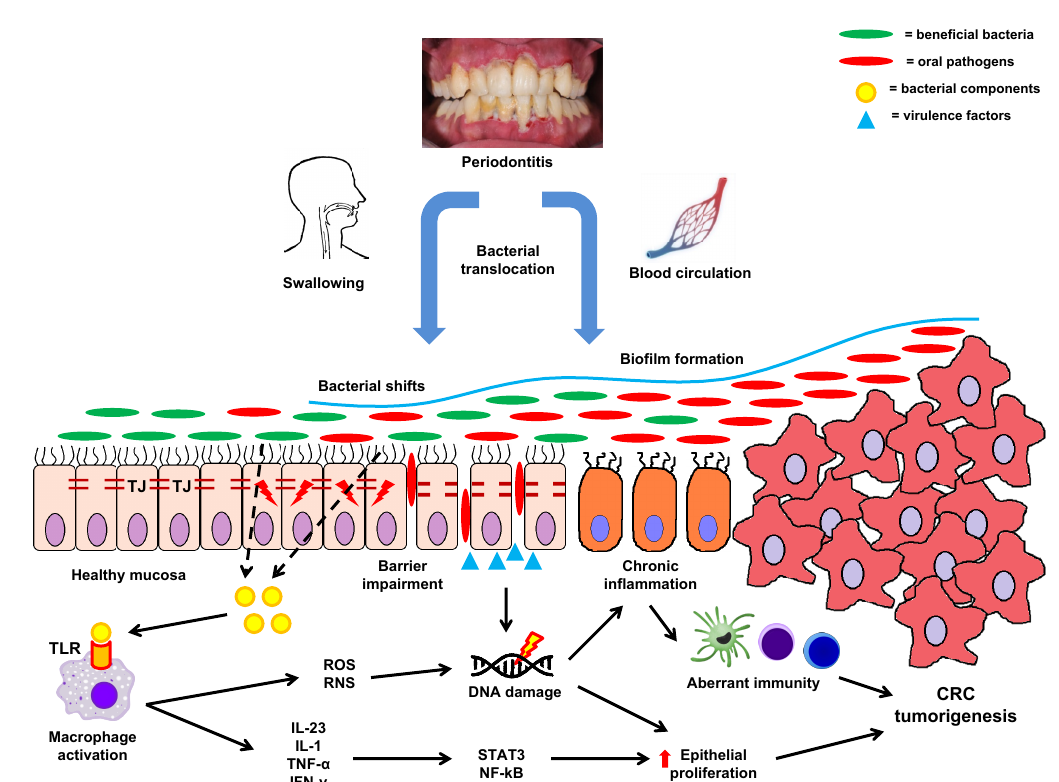
Figure 2. A proposed model of orally-driven intestinal dysbiosis in CRC development. In periodontitis several oral pathogens, such as Fusobacterium nucleatum or Porphyromonas gingivalis , are abundant in oral biofilms. This situation aids the dissemination of oral pathogens into the colon via either swallowing of the saliva or bloodstream. In the colonic environment they are incorporated into the intestinal microbiota. As a result, bacterial shifts and the production of virulence factors create a microbiotic instability and outgrowth of pathogens leading to intestinal dysbioisis. Subsequent biofilm formation and secretion of several bacterial components (e.g., metabolites, toxins, MAMPs), lead to macrophage activation and disruption of the mucosal barrier. Pro-inflammatory cytokines, such as IL-23, IL-1, TNF- α , and IFN- γ , enable signaling pathways through STAT3 and NF- κ B activation, enhancing the proliferation of epithelial cells. Moreover, the release of ROS and RNS and the increased exposure of submucosal environment by virulaence factors and other bacterial products or toxins result in DNA damage and mutations. These events promote a chronic inflammatory state which stimulates an aberrant immune response and further impairs the colonic epithelium. Inevitably, the result of the above interactions is the initiation and progression of CRC carcinogenesis. CRC: colorectal